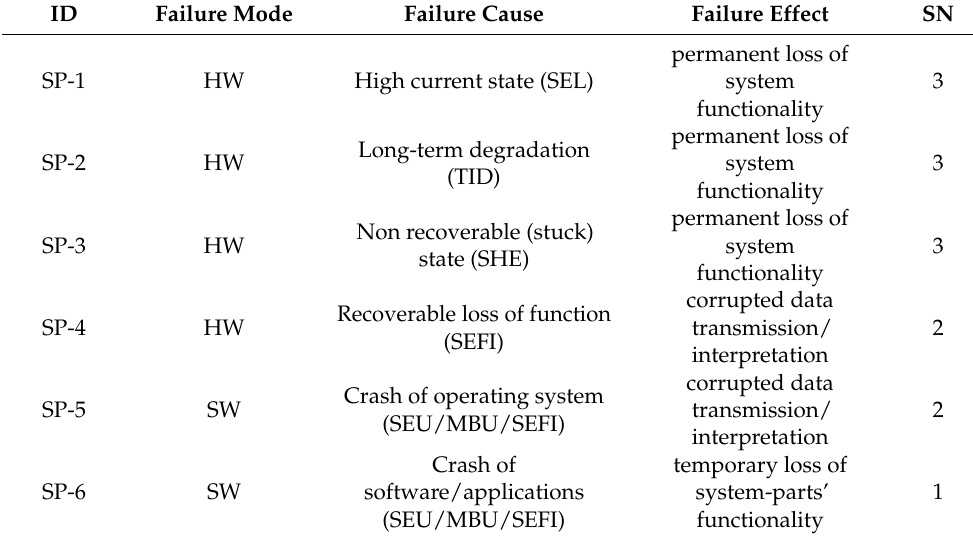
Table 5. FMECA result for the signal-processing block.